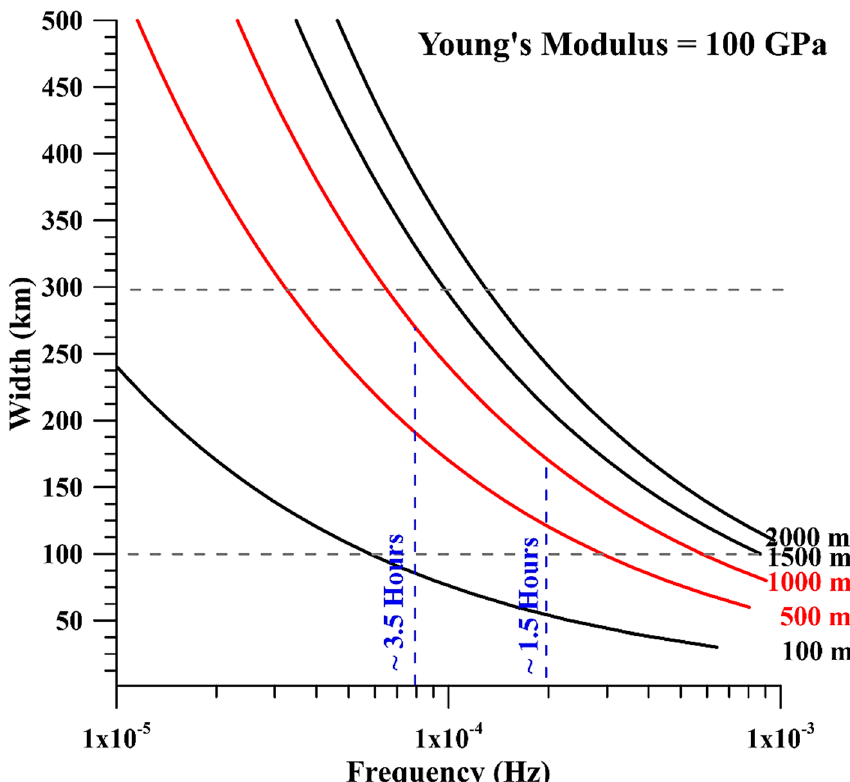
Figure 7. Relationships between the width and thickness of a square sheet and its resonant frequency. We assume that the shaking area is a square sheet with all sides simply supported. According to Leissa [33], the resonant frequency of such a square sheet can be estimated using the formula 2 f = 1 ρ= + 2 2 π , where E is Young’s modulus, h is the thickness of the υ sheet, ρ is the mass density, υ is Poisson’s ratio, a and b are the widths of the plate, and m and n are integers. In this study, a equals b as the sheet is square. Young’s modulus and average density of the crust are 100 GPa and 2700 kg/m3, respectively. Poisson’s ratio is 0.3. Red and black lines indicate the relationships between the width and resonance frequency computed at varying thicknesses. Notably, m and n are taken as 1 to estimate the relationship based on a fundamental mode. The common-mode vibrations can be potential sources of other pre-earthquake anomalous phenomena. Geomagnetic data show the amplification in the particular frequency band (1.5–3.5 h periods) for 5–15 days before the Meinong and Parkfield earthquakes (Figures S17–S19). This generally agrees with the observations of the amplification from seismic and GNSS data, as shown in this study (Figures 1, 3, 4, S2–S4). Numerous earlier studies reported that the seismo-ionospheric